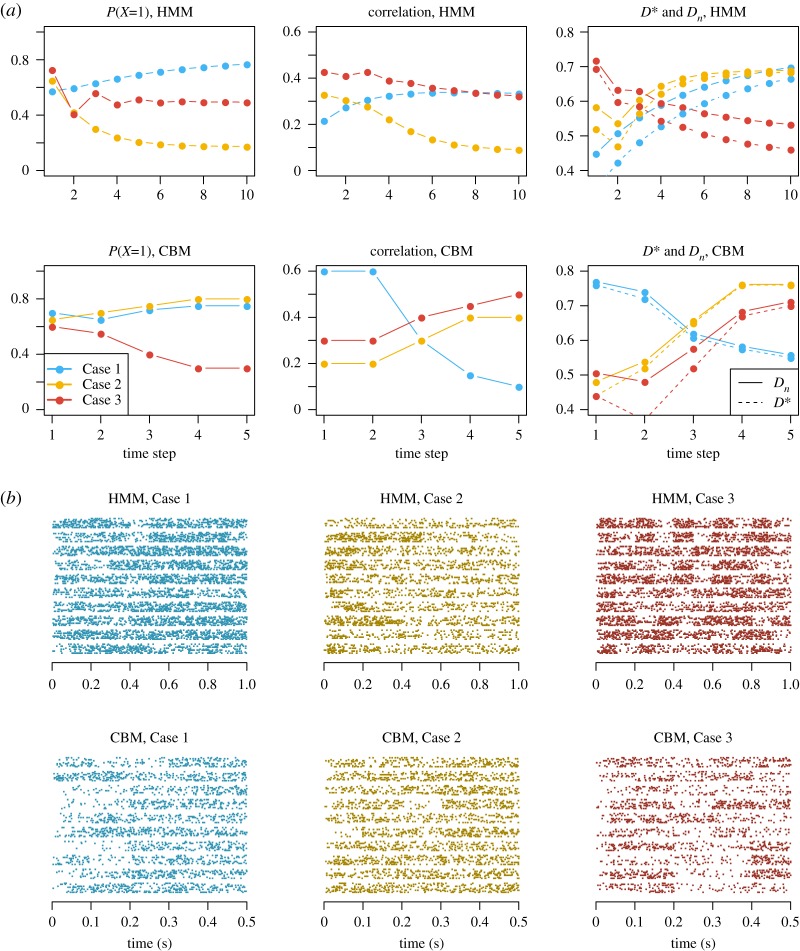
Examples of simulated data for the HMM and the CBM. (a) The probabilities of attending the contralateral stimulus, p (left), the pairwise correlation coefficients ρ (middle) and the deviation statistic values Dn and D* (right) are shown as functions of time. Different colours represent the three parameter settings. (b) Example spike trains are shown for the corresponding case and model. In each sub-figure, 10 trials are shown, separated by horizontal white space lines. In each trial, 10 simultaneous spike trains are plotted.